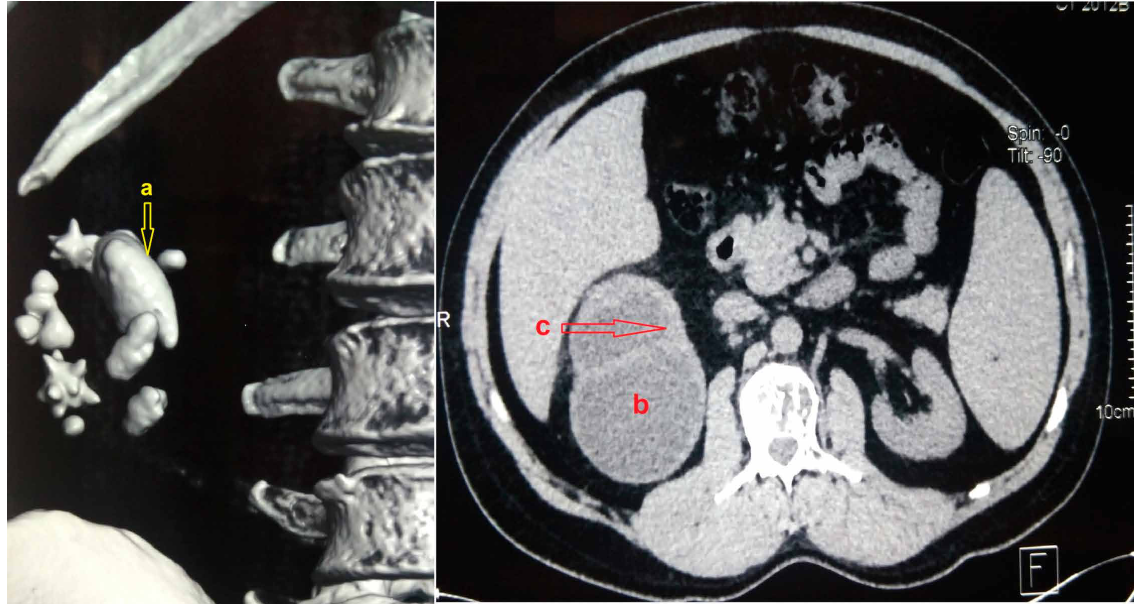
Figure 1: CT scan demonstrating large renal calculi and upper pole hydronephrosis: (a) large right renal pelvic calculi; (b) upper calix hydronephrosis; (c) thinned surrounding renal cortex.